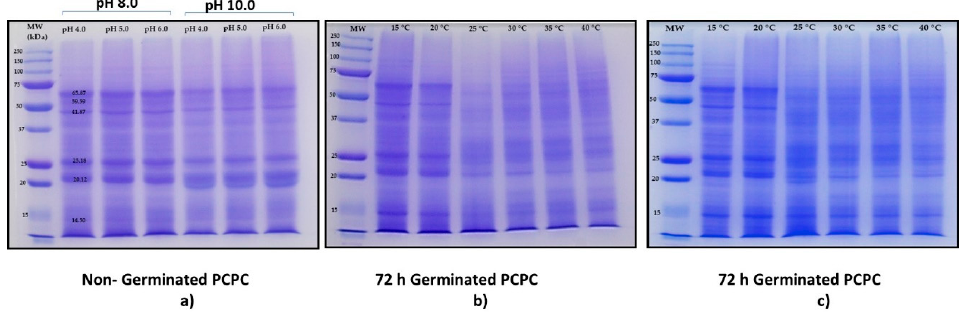
Figure 2. Analysis of protein profile of purple corn protein phenolic concentrates (PCPC) by sodium dodecyl sulfate-polyacrylamide gel electrophoresis (SDS-PAGE). ( a ) Non-germinated PCPC obtained at (pH 8.0 and pH 10 alkaline extraction) and different pHs of precipitation; ( b ) germinated PCPC at (pH 8.0 alkaline and pH 4.0 of precipitation) for 72 h; ( c ) germinated PCPC at (pH 10 and pH 4.0 of precipitation) for 72 h.